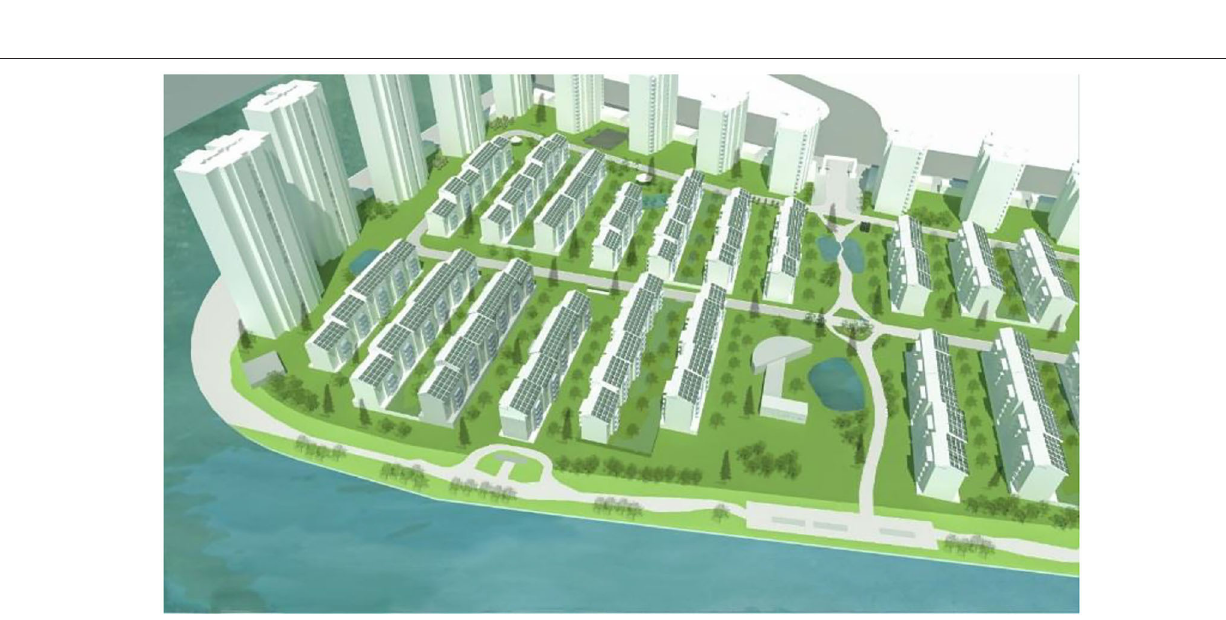
Frontiers in Sustainable Cities |